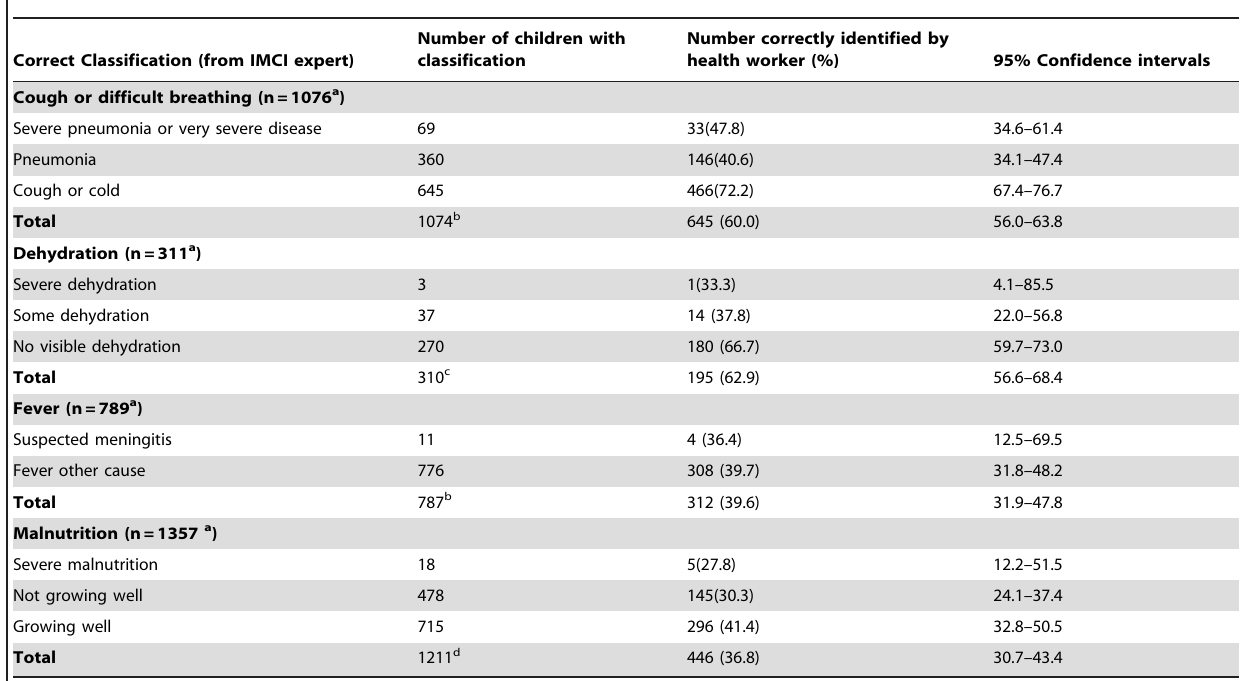
Table 4. Proportion of classifications correctly identified by health workers.